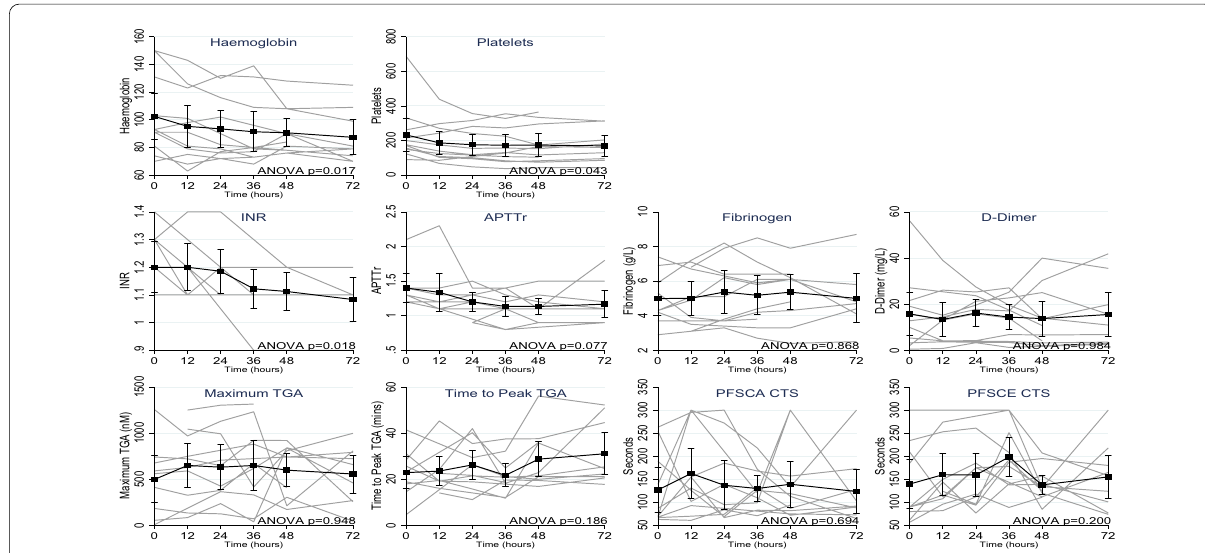
Fig. 2 Changes in systemic measurements of coagulation over duration of treatment. INR International Normalised Ratio, APTTr activated partial thromboplastin time ratio, TGA thrombin generation assay, PFSCA platelet function assay using collagen/adenosine diphosphate, PFSCE platelet function assay using collagen/epinephrine, CT closure time. Repeated measures ANOVAs compared systemic parameters from baseline to 48 h. Post hoc pairwise comparisons found significant differences between haemoglobin at baseline and 36 h ( p 0.030) and baseline and 48 h ( p 0.018); = = platelets at baseline and 36 h ( p 0.035) and baseline and 48 h ( p 0.040) and INR at baseline and 36 h ( p 0.034) and baseline and 48 h = = = ( p 0.024). There were no significant differences in systemic parameters on CRRT =